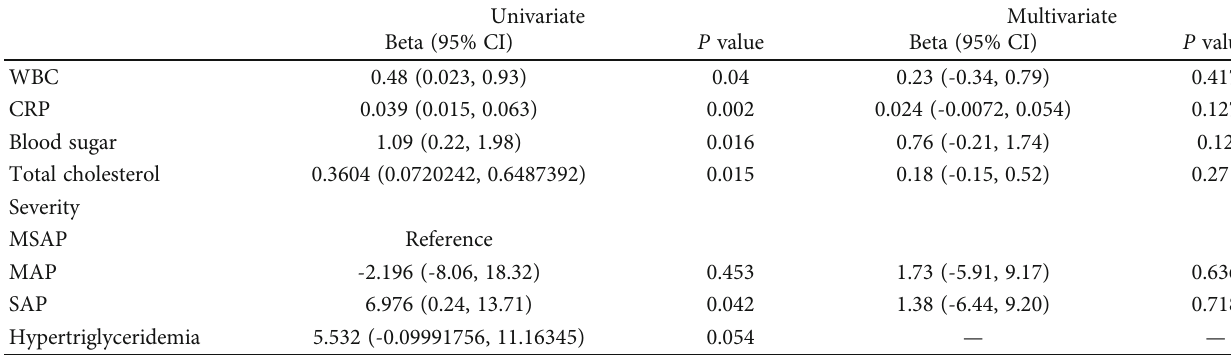
Table 6: Factors a ff ecting the length of hospital stay at